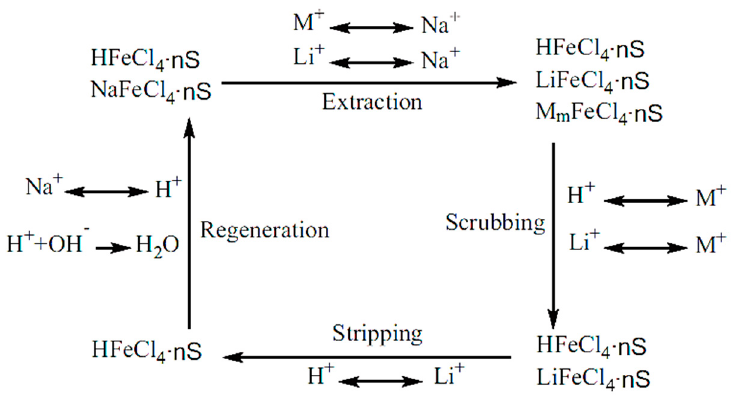
Figure 5. Solvent extraction process principle [55]. M refers to Na + , K + , Mg 2+ , Ca 2+ and S refers to extractants.